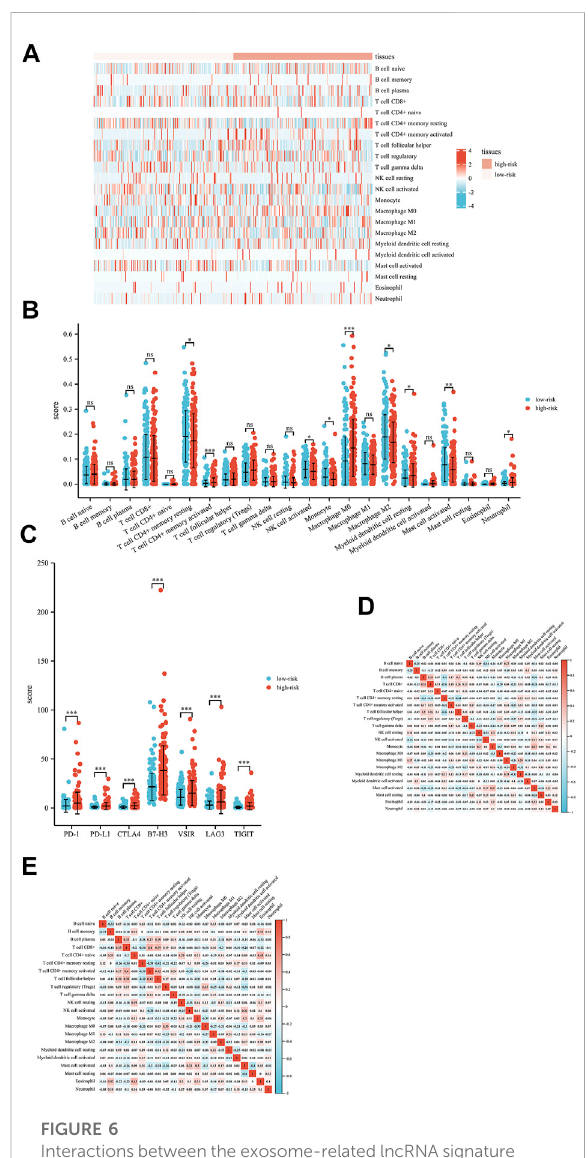
FIGURE 6 Interactions between the exosome-related lncRNA signature and immune regulation inliver cancer patients. (A) Heatmap ofthe tumor-in fi ltrating immune cell in low-risk and high-risk patients. (B) Comparisonsofimmunecellsbetweenthelow-riskgroup and high-risk group. (C) Comparisons of multiple immune checkpoints between the low-risk group and high-risk group, including PD-1, PD-L1, CTLA4, B7-H3, VSIR, LAG3 and TIGIT. (D) Correlation matrix of immune cells in high-risk group patients. (E) Correlation matrix of immune cells in low-risk group patients. * p